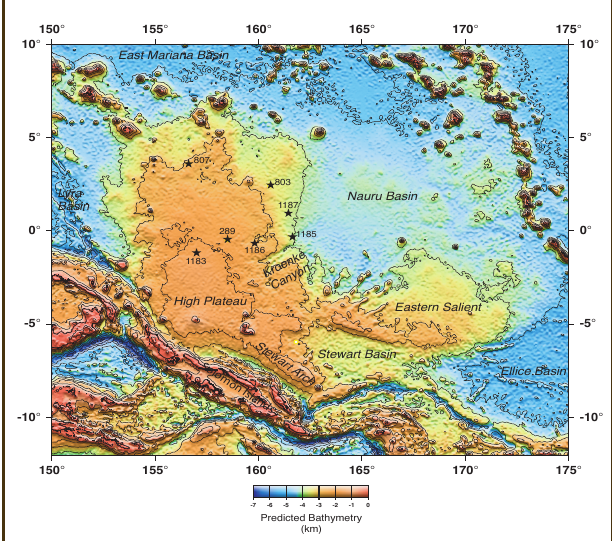
Figure 4. Bathymetry of the western Pacific Ocean including features of the Ontong Java Plateau and surrounding basins. Numbered stars represent DSDP Leg 30, ODP Leg 130, and ODP Leg 192 drill sites that penetrated and recovered igneous